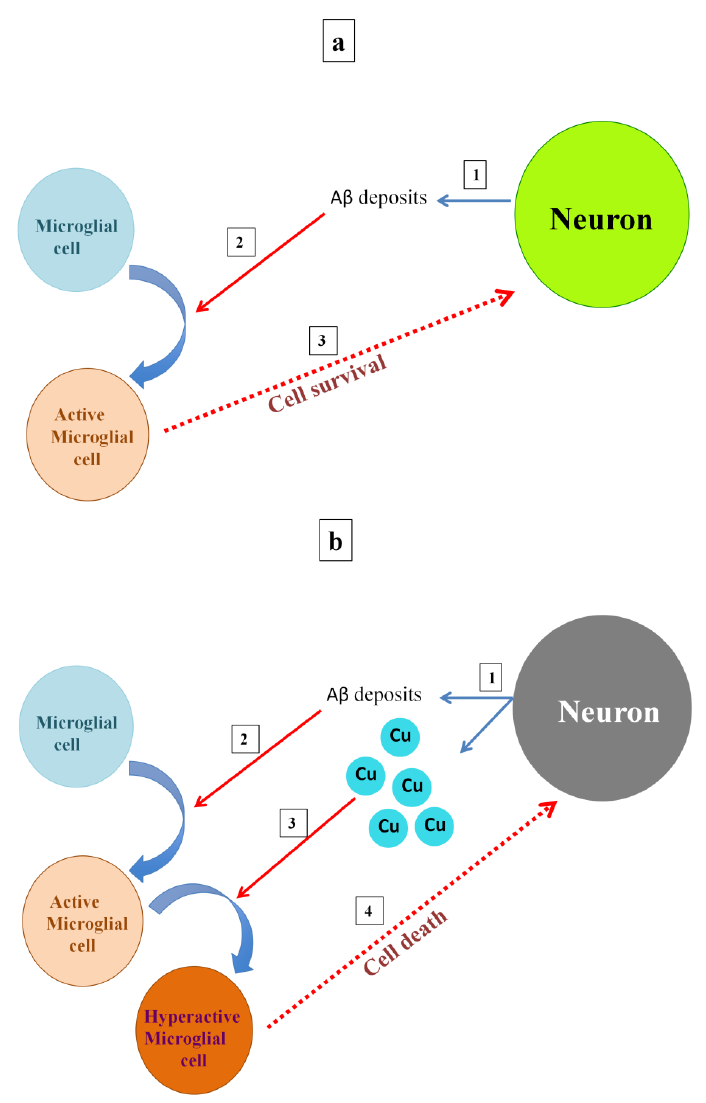
Figure 2. Model of microglia’s dual role in AD. The activation of microglia is key to neuronal survival ( a ). The presence of large amounts of copper in the synapse changes the role of microglia from protective to lethal and also induces neurons’ copper deficiency ( b ).